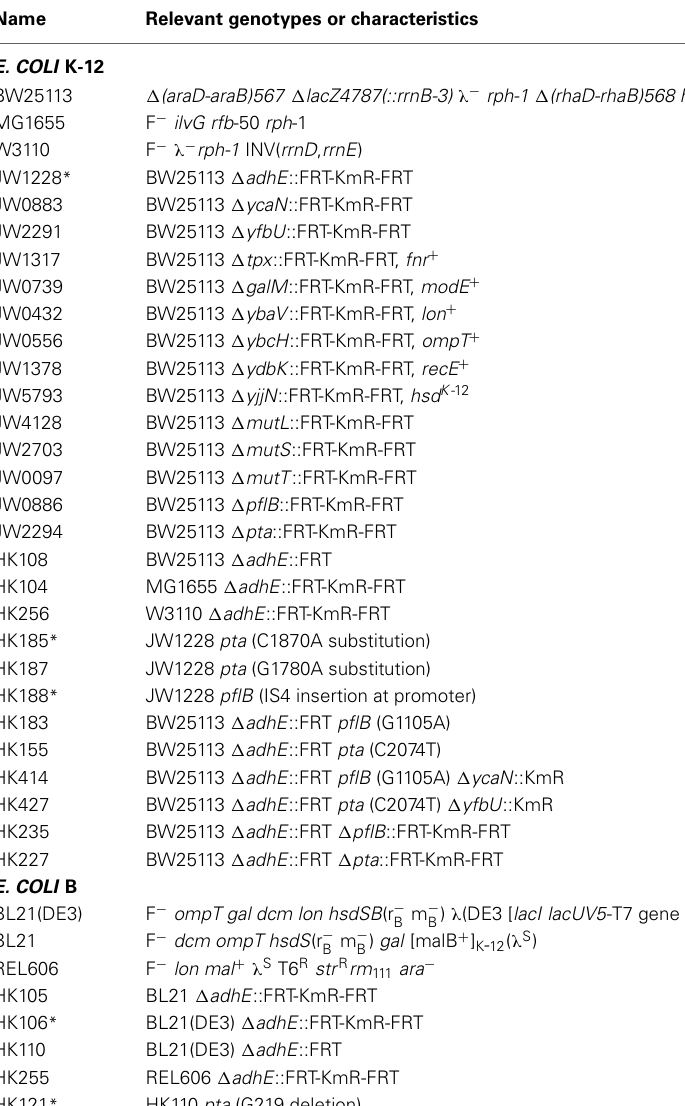
Table 1 | Bacterial strains, phages, and plasmids used in this